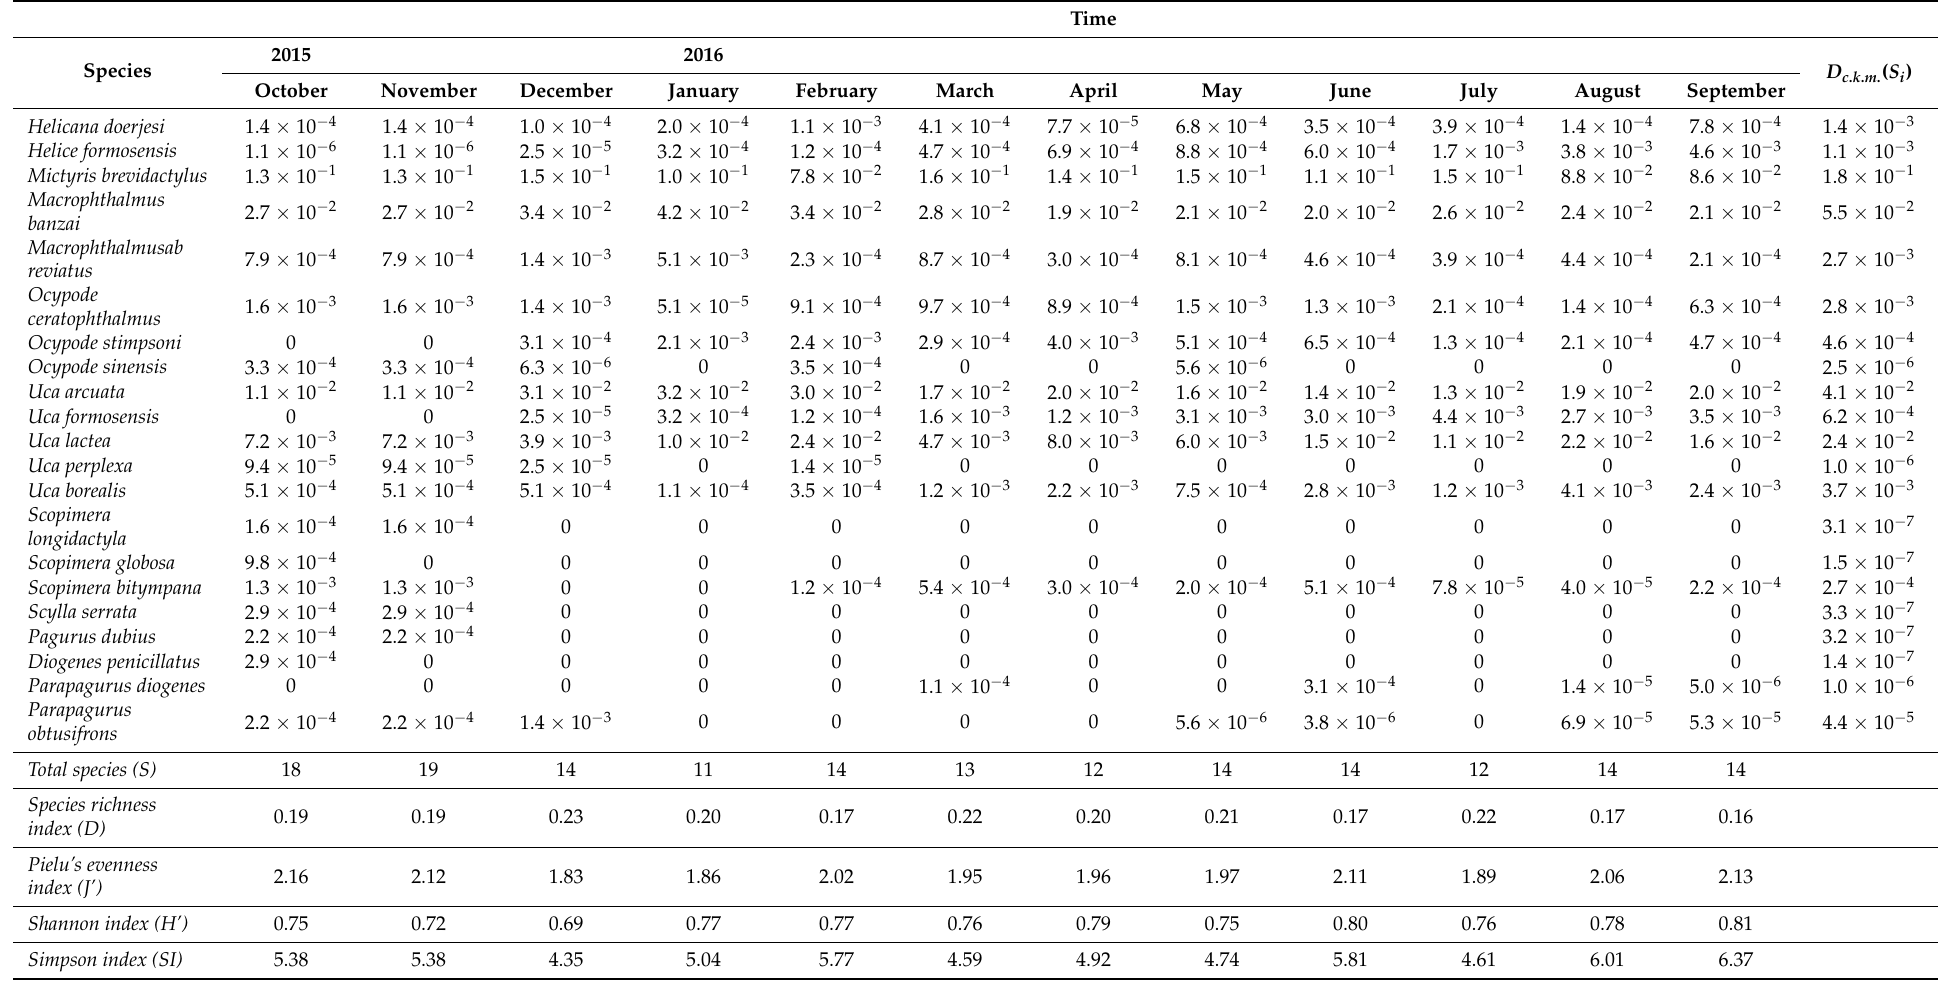
Table A4. Probabilities of contribution to biodiversity ( D c.k.m. ) by crab species ( S i ) by